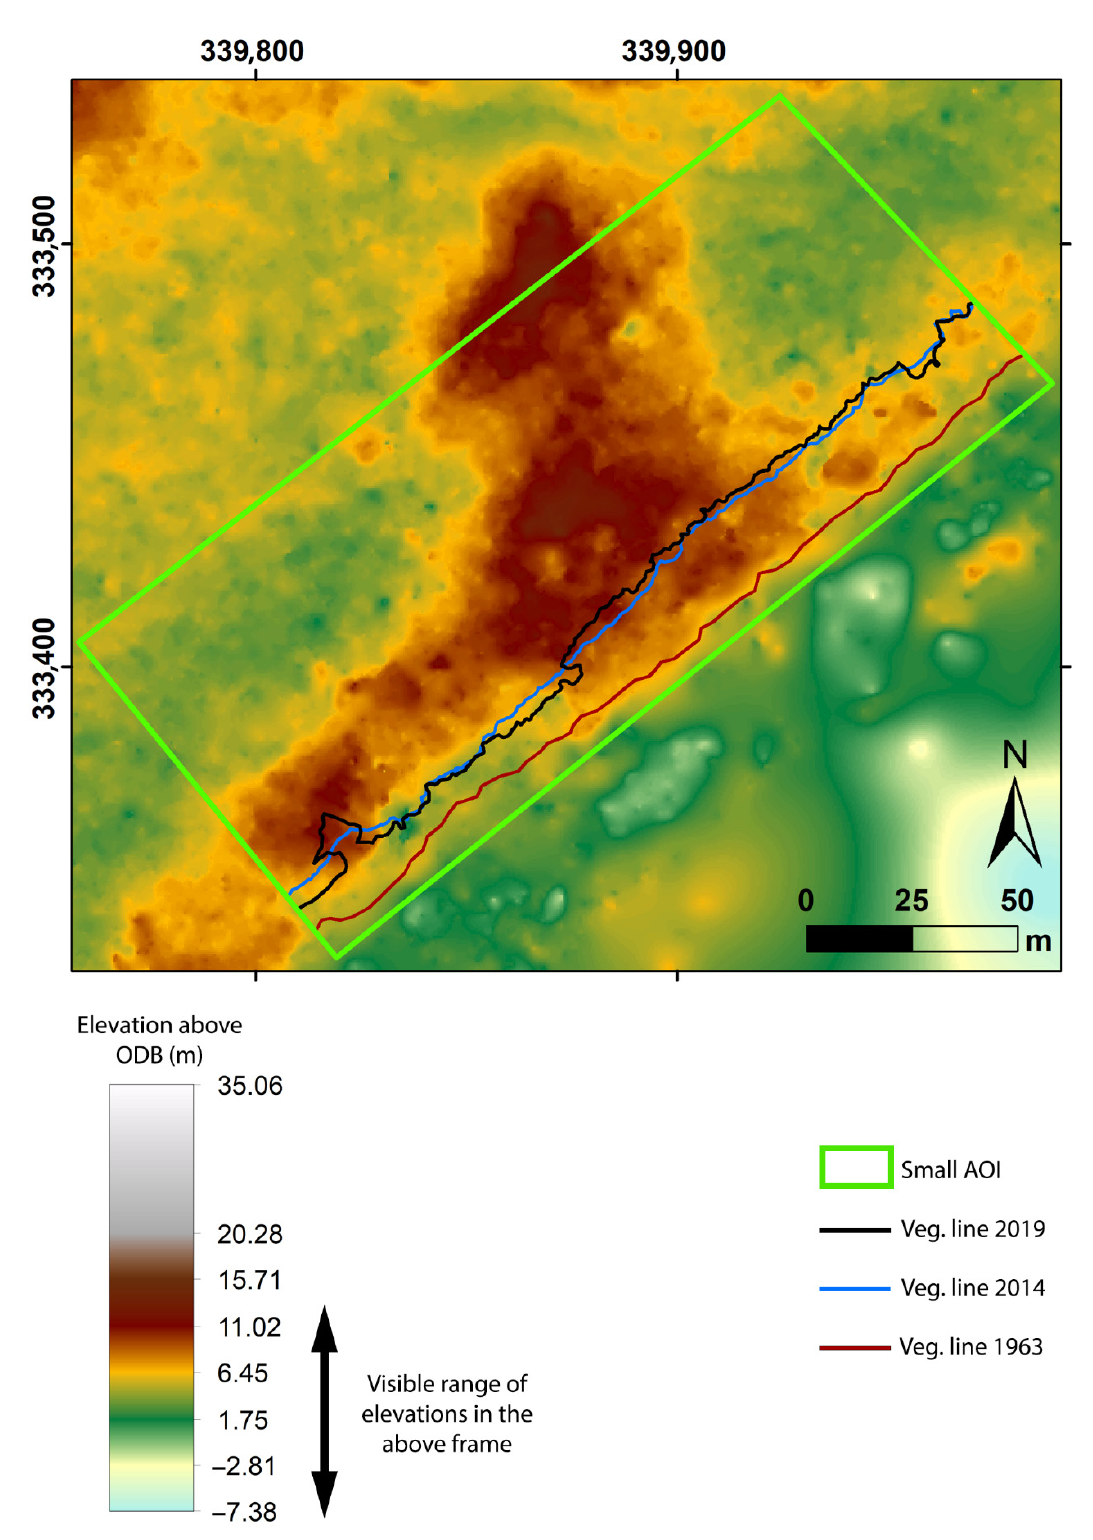
Figure 10. Small area of interest showing the best 1963 digital surface model (DSM) resulting from the structure-from-motion process. Shorelines (vegetation lines) from 1963, 2014, and 2019 are superimposed on the 1963 DSM. The graticule is in TM75/Irish Grid (transverse mercator) projection and elevations are above the Ordnance Datum Belfast